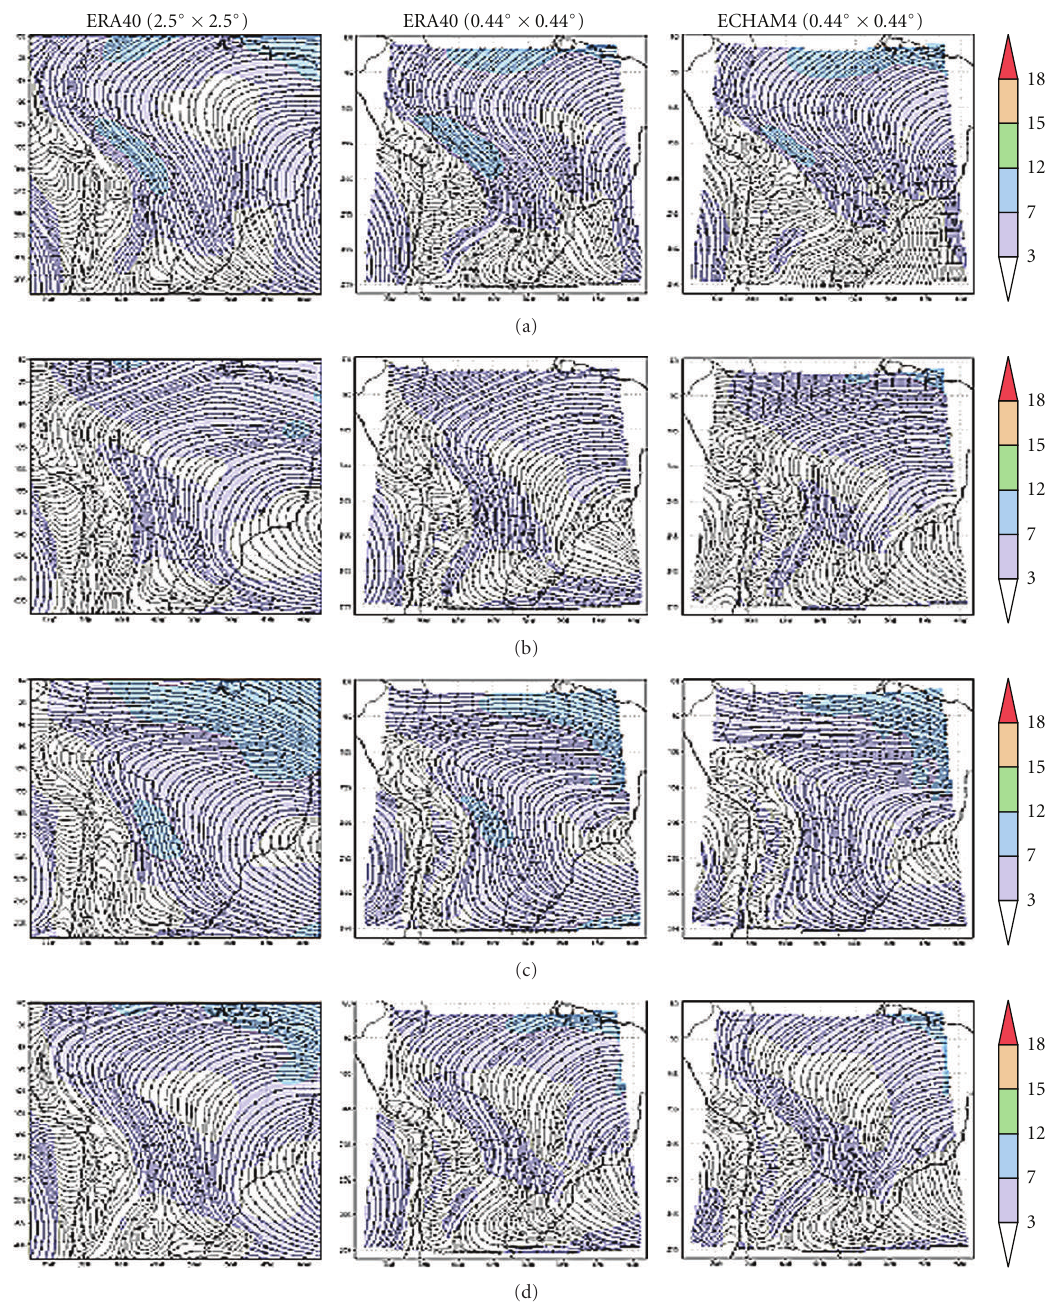
Figure 2: Isolines and wind intensity for 40 years (1961–2000) mean wind field (m/s) at 850 hPa for (a) summer (DJF), (b) autumn (MAM), (c) winter (JJA), and (d) spring (SON). Original ERA-40 2 . 5 ◦ × 2 . 5 ◦ data (left column) and PRECIS outputs for runs driven by ERA-40 C (center column) and ECHAM4 (right column). Wind intensity is